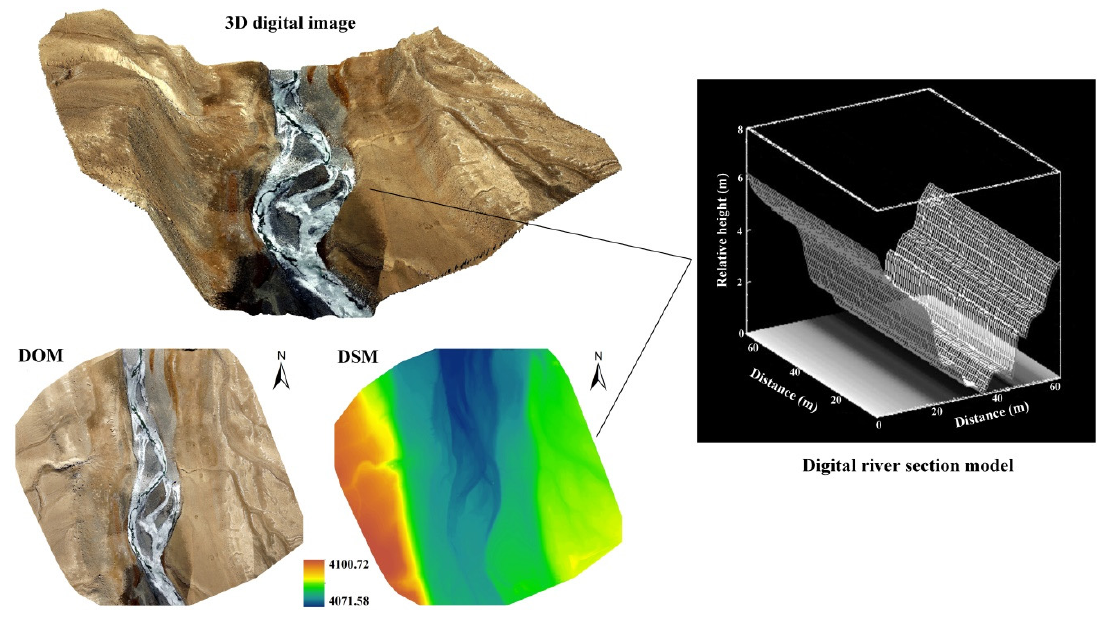
Figure 2. River section information obtained from UAV.